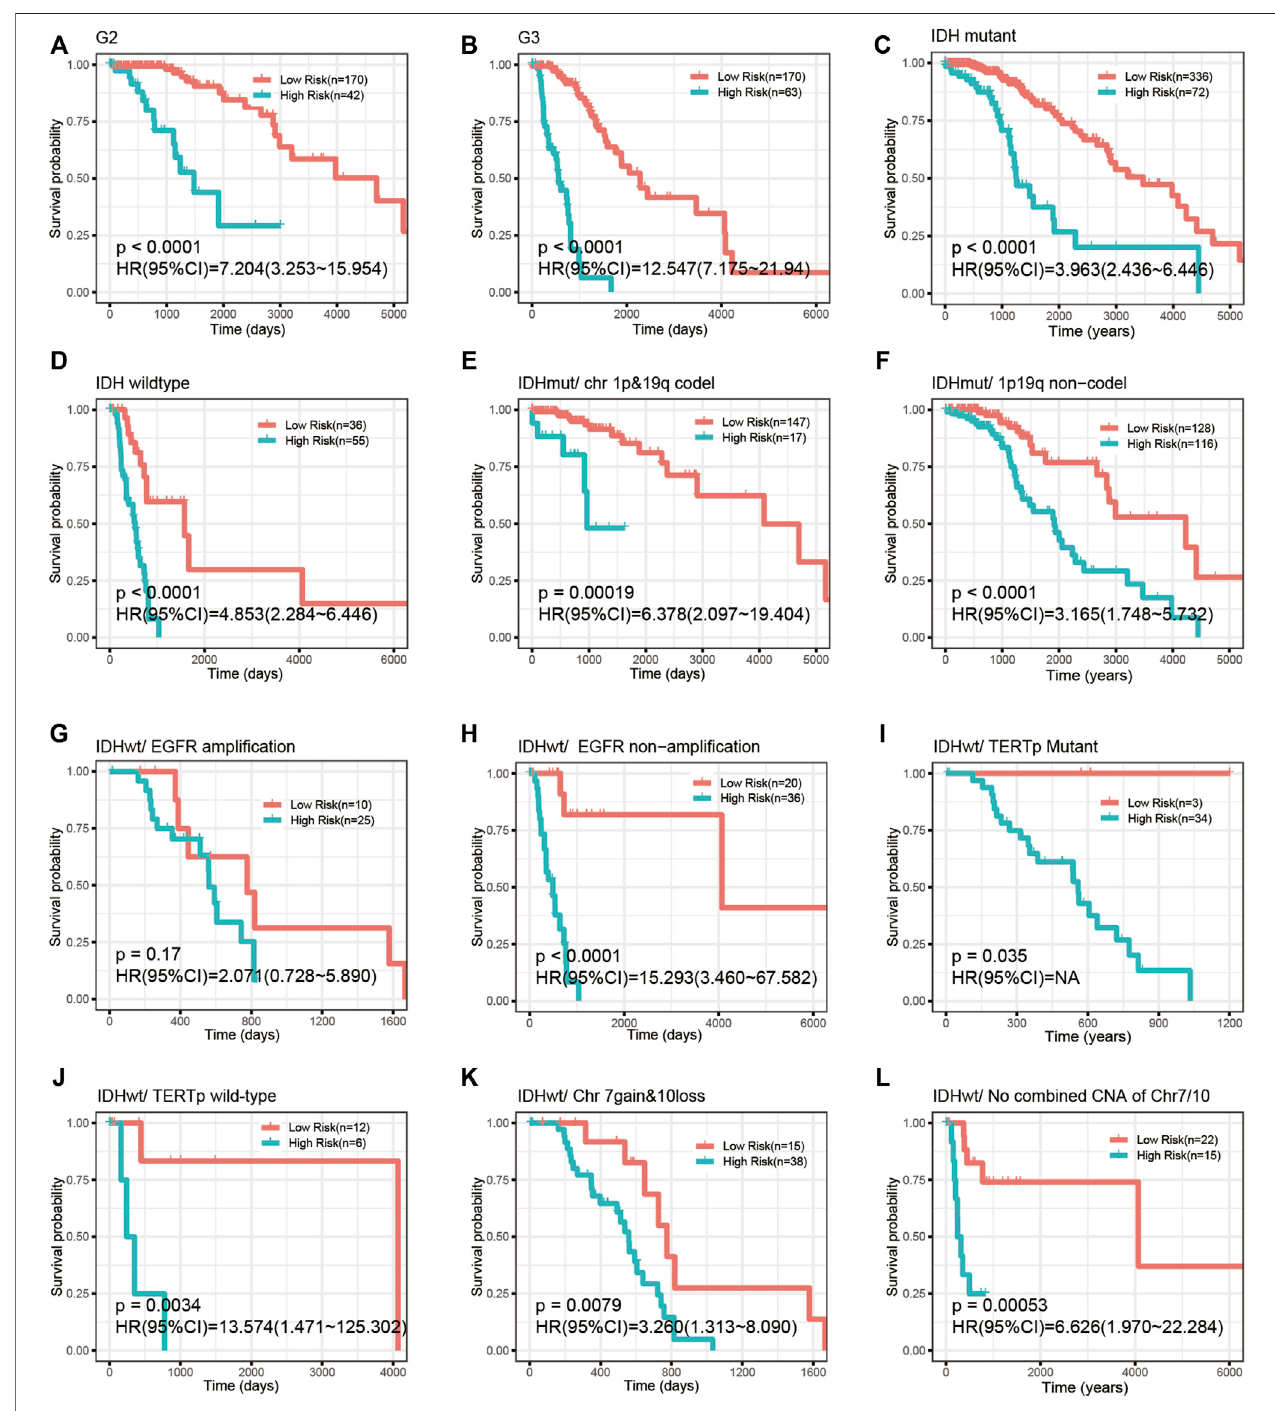
FIGURE 6 | The CpG signature remained prognostically signi fi cant in LGGs strati fi ed by common variables. (A – D) Kaplan-Meier analysis of the CpG signature in LGGs strati fi ed by histological grade (A,B) and IDH mutation (C,D) . (E,F) Kaplan-Meier analysis of the CpG signature in chromosome 1p/19q codeletion-strati fi ed IDH- mutant LGGs. (G – L) Kaplan-Meier analysis of the CpG signature in IDH wild-type LGGs strati fi ed by EGFR ampli fi cation, TERT promoter mutation and combined chromosome 7gain/10loss.